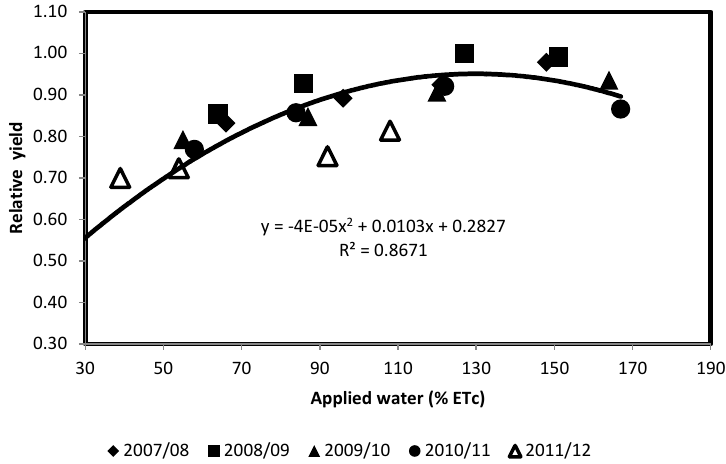
Means followed by a different letter within a given year are significantly different at P < 0.05.